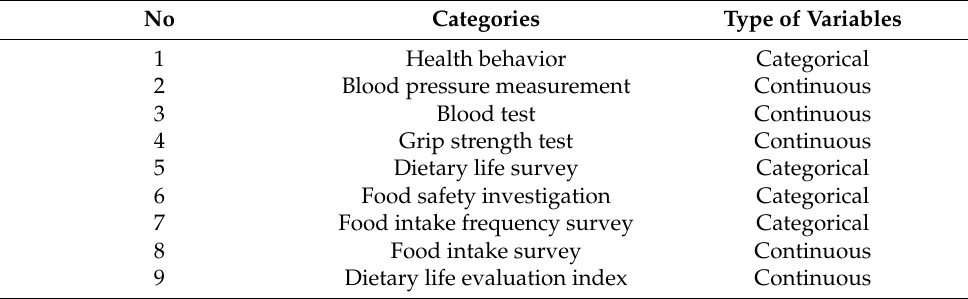
Table 1. Categories of variables in the KNHANES dataset.